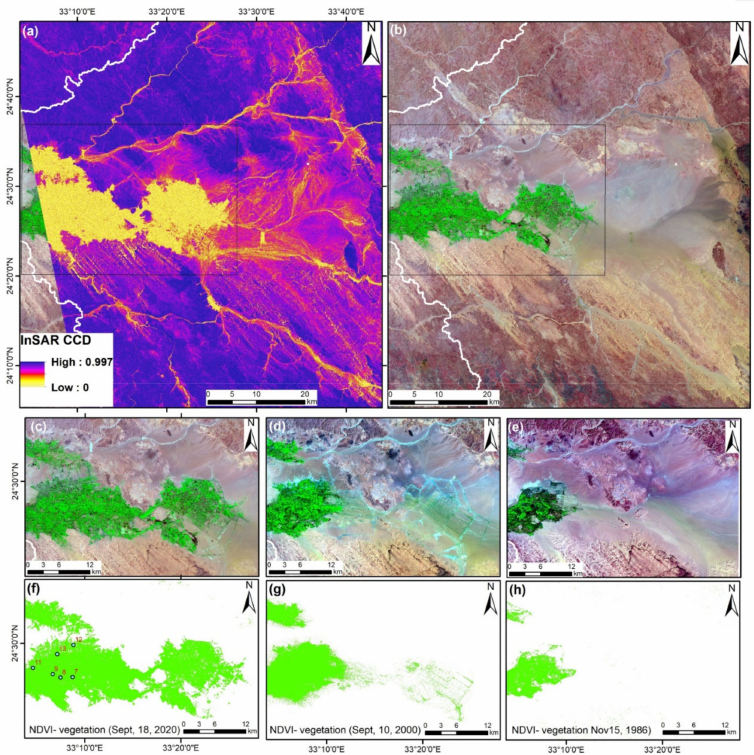
Figure 14. ( a ) InSAR CCD of the downstream area showing active streams in yellow and vegetation in comparison to Landsat-8 in ( b ); ( c – e ) Landsat images of years 2020, 2000, and 1986, respectively. ( f – h ) NDVI vegetation derived from Landsat images of years 2020, 2000, and 1986,